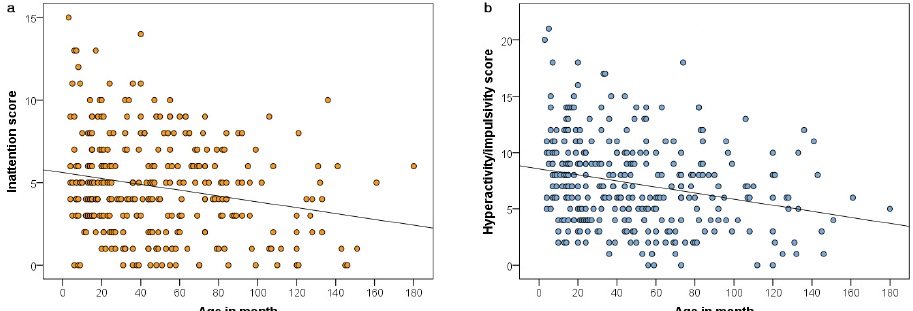
Figure 1. Greater age is associated with lower inattention ( a ) and with lower hyperactivity/impulsivity ( b ). The regression lines are default SPSS fitted lines representing trends in the data, with the slope corresponding to the unstandardized regression coefficient b of a linear regression equation, where Y = a (i.e., intercept) + bX (in this case, for inattention-age: y = 5.6 + − 0.02 * x and y = 8.56 + − 0.03 * x for hyperactivity/impulsivity-age). Note. The coloured circles represent subjects.